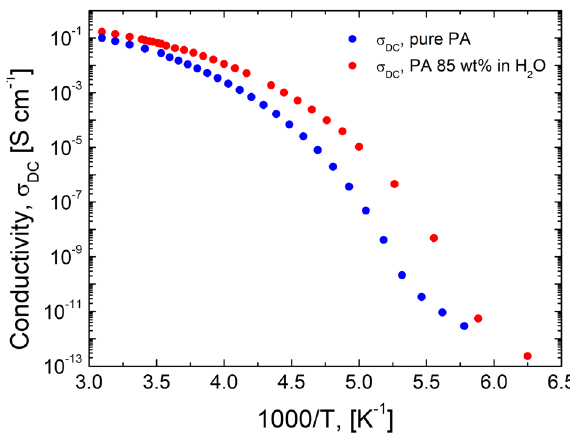
Fig. 2 Temperature dependence of the DC-conductivity. Temperature dependence of the DC conductivity, σ DC , for pure PA (blue symbols) and PA85 (red symbols).